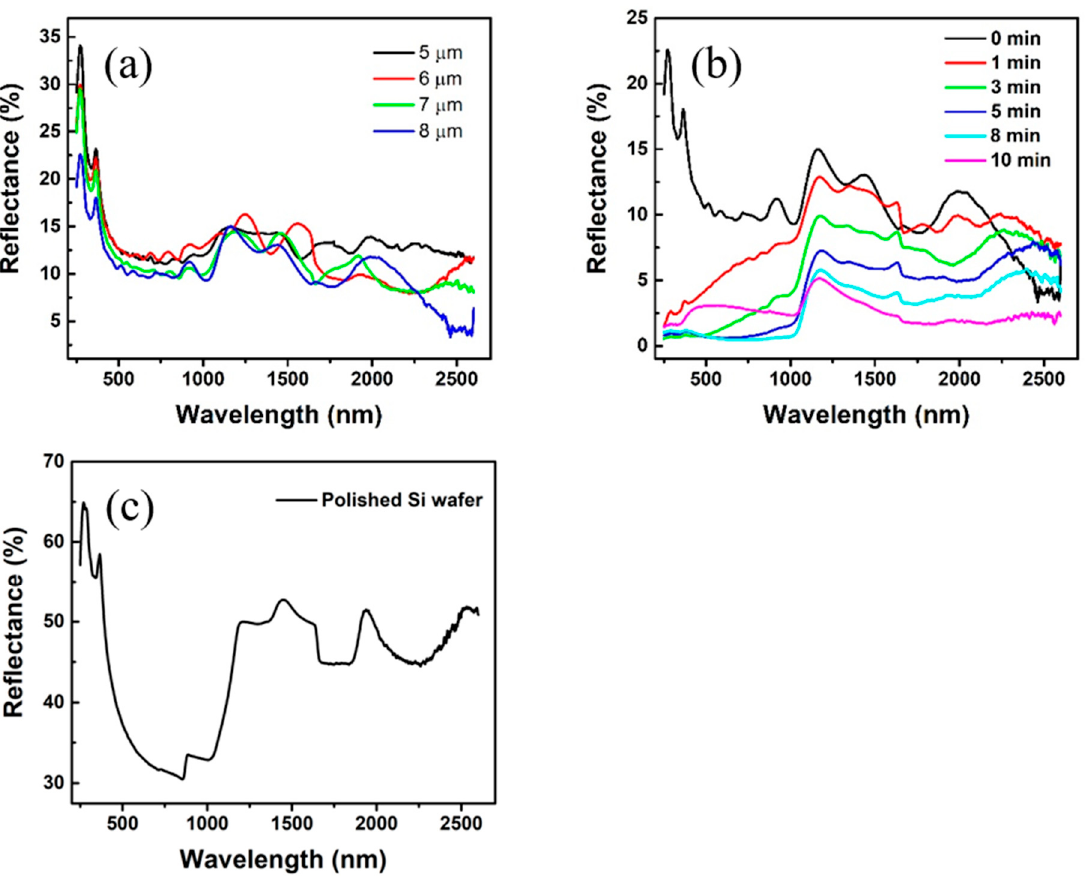
Figure 4. Reflectance spectra from 250 nm to 2600 nm for annealed inverted pyramidal arrays ( a ) with periods of 5, 6, 7 and 8 μ m before MacEtch process; ( b ) with period of 8 μ m treated by the MacEtch processes for 0, 1, 3, 5, 8, 10 min; ( c ) Specular reflection for polished Si wafer from 250 nm to 2600 nm.